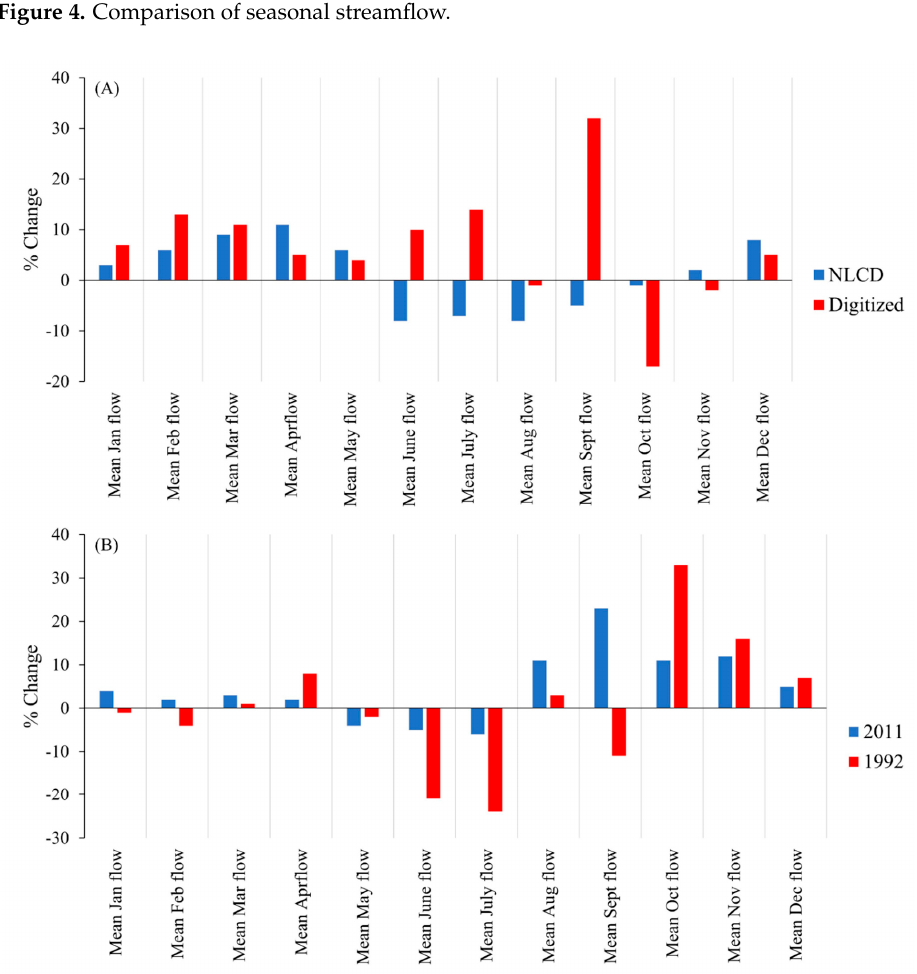
Figure 5. Changes in monthly streamflow. Percent differences in the magnitude of monthly streamflow due to the source of LULC data ( A ) and due to the temporal condition of LULC distribution in the watershed using 1992 and 2011 LULC data ( B ).